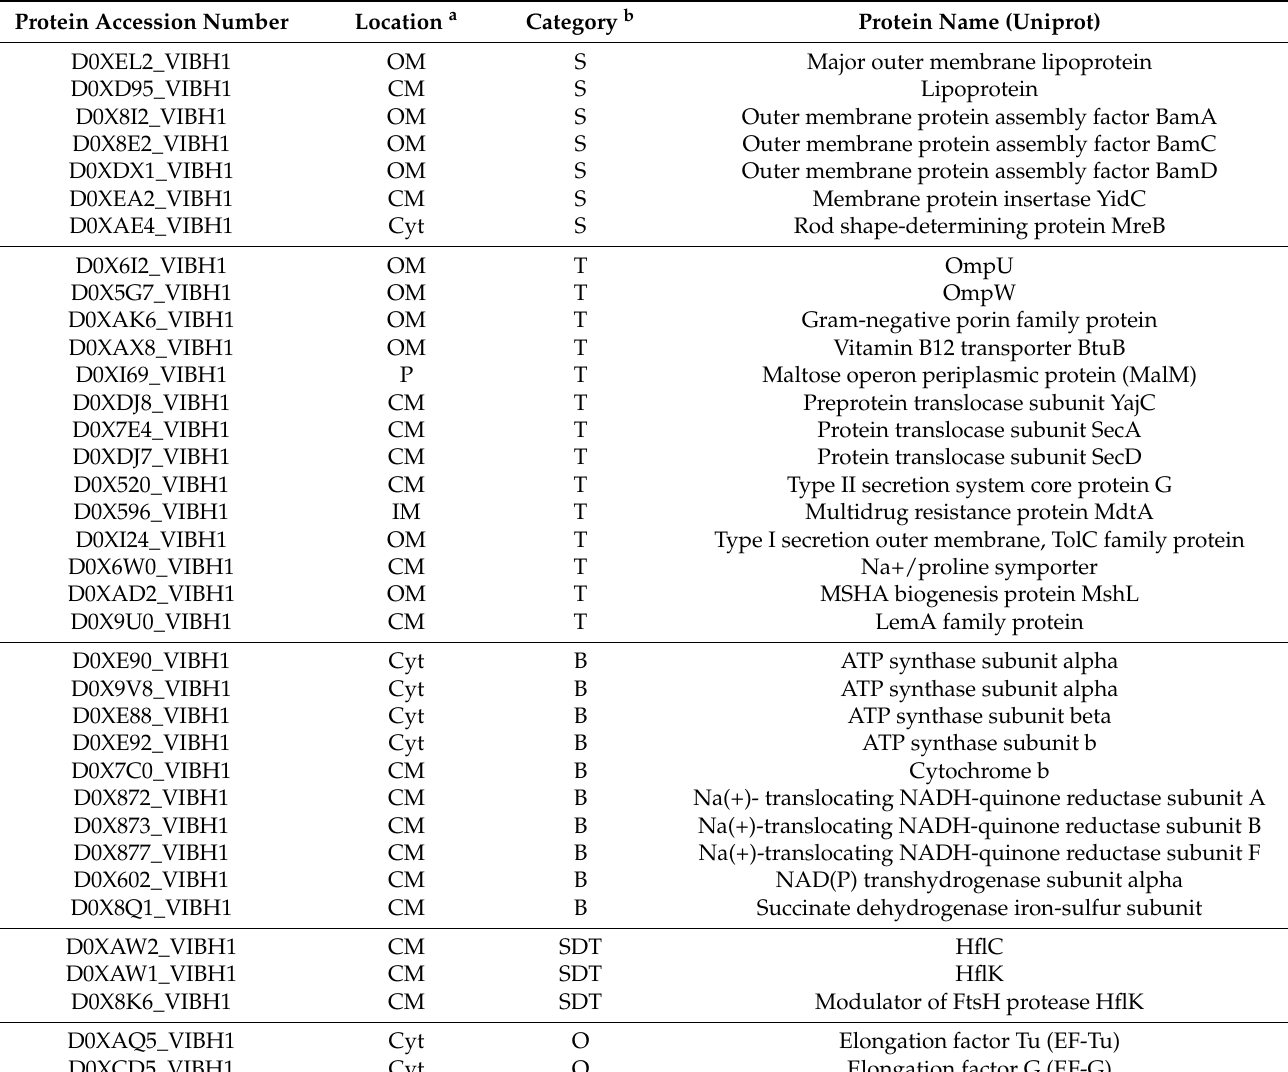
factors EF-Tu and EF-G). Table 1. Membrane proteins of V. harveyi ATCC 14126 T whose level did not show a significant change (>1.5 or <0.5 fold change) after 6 days (P1), and 21 days (P2) of starvation in seawater at 20 ◦ C with respect to initial values (P0). Protein Accession Number Location